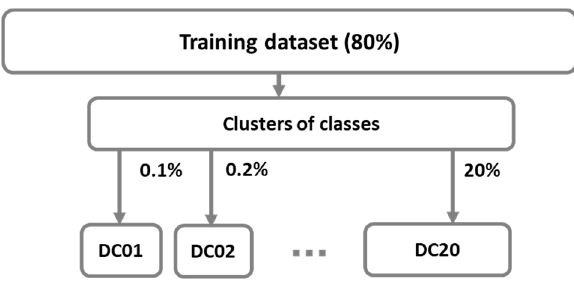
Figure 5. Determination of balanced datasets DCi with selection of representative samples using clustering method.